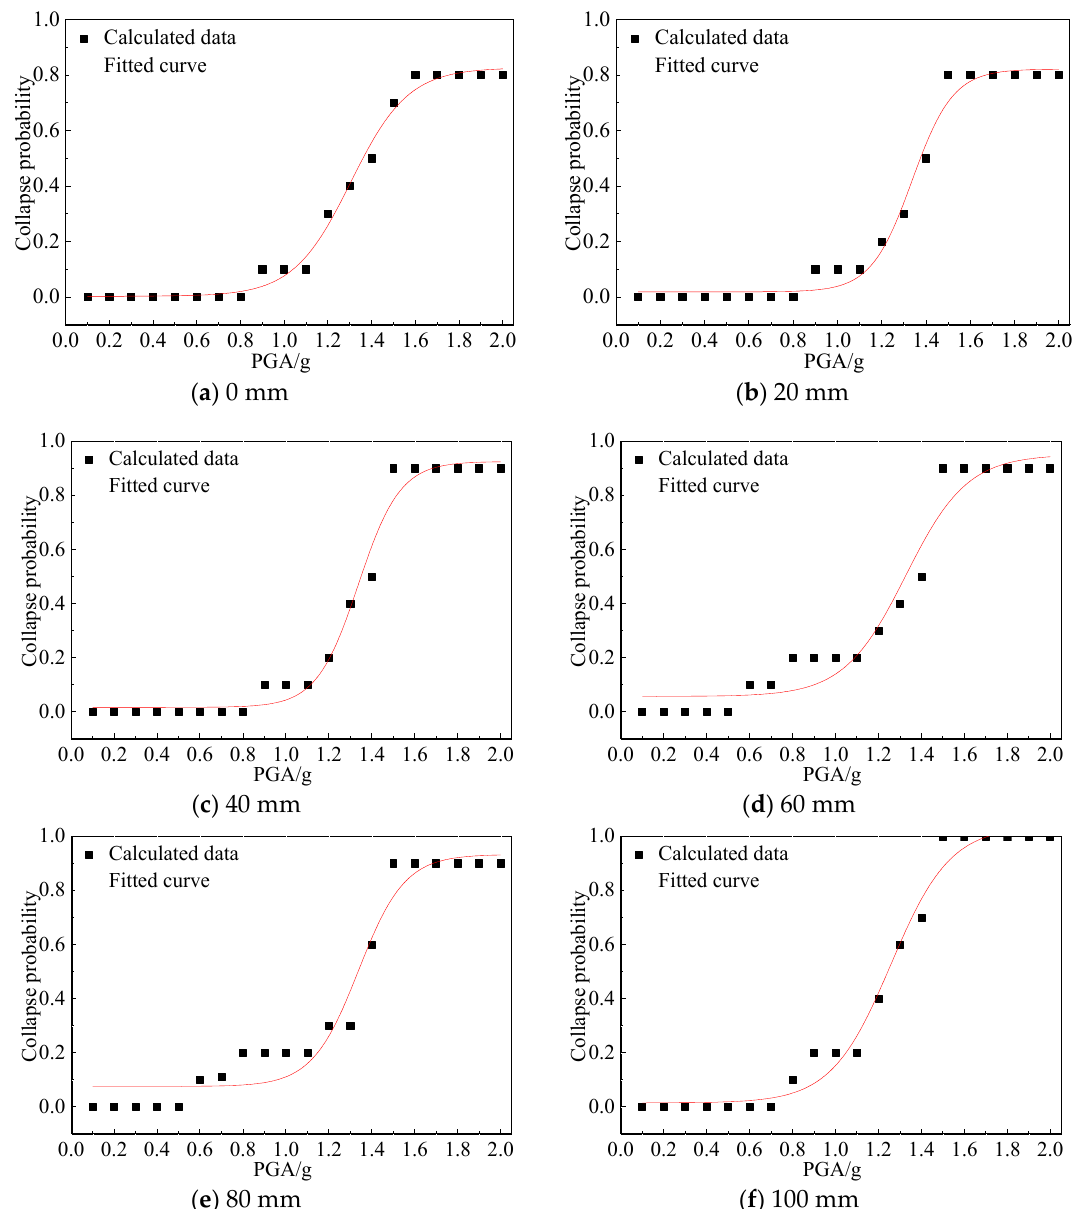
Figure 6. Collapse probabilities of structures with different uneven settlement quantities in Zone I.